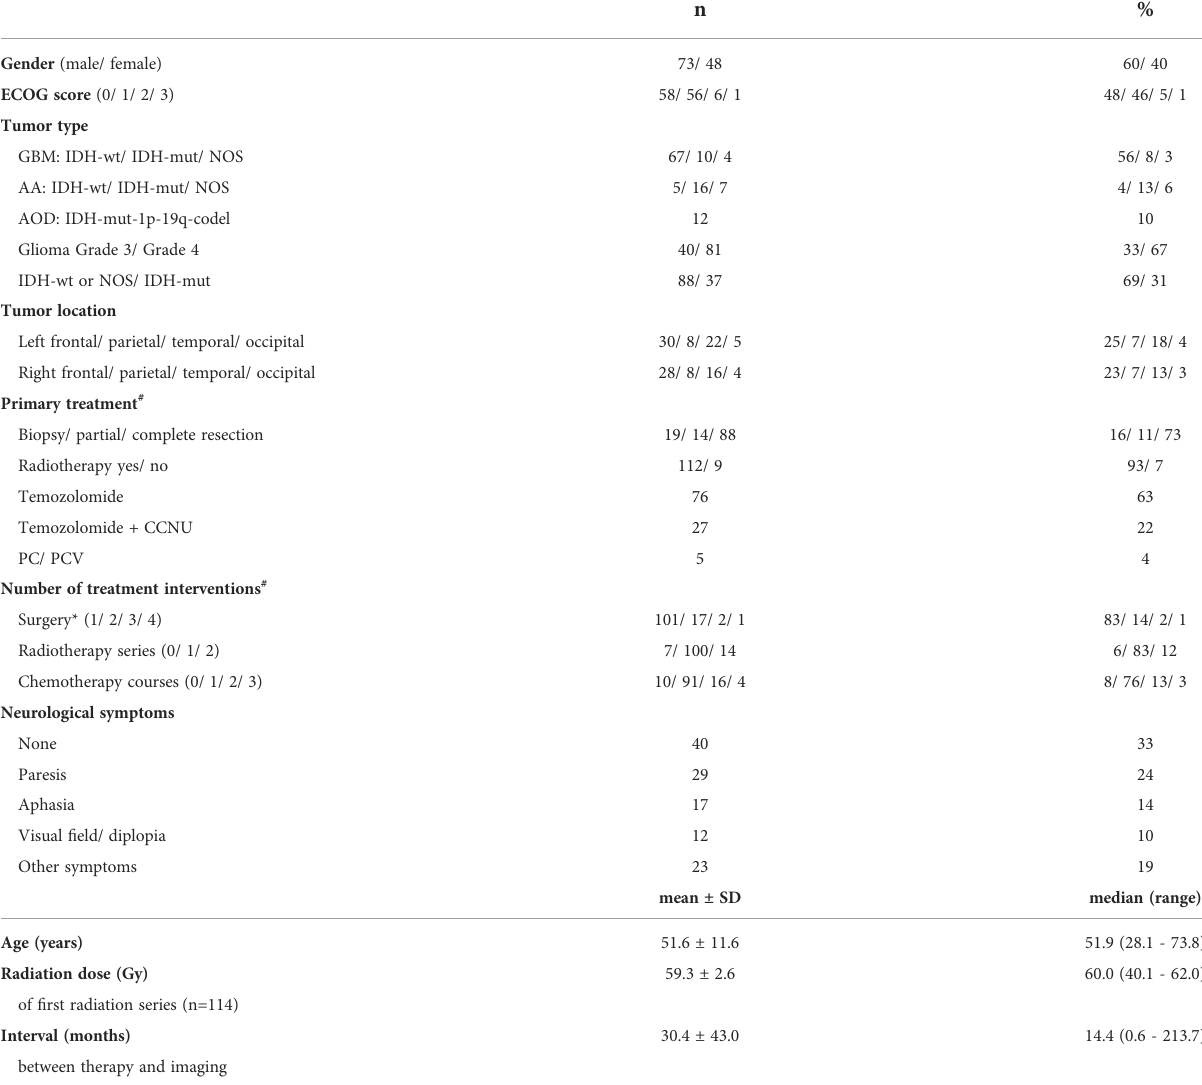
TABLE 1 Patient